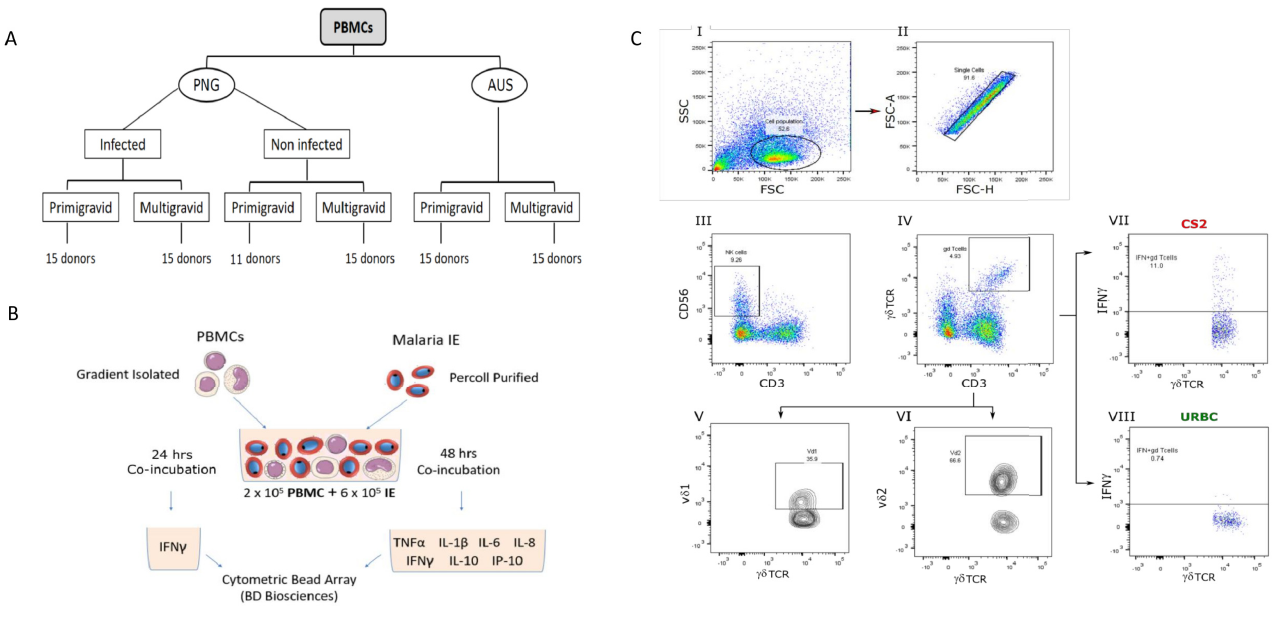
Fig 1. (A) Stratification of study population: PBMC derived from pregnant women from Papua New Guinea (PNG) and Australia (AUS) were categorized into six test groups based on sample origin, gravidity and current malaria infection. From PNG: infected primigravidae (15), infected multigravidae (15), non-infected primigravidae (11) and non-infected multigravidae (15). From Australian: primigravidae (15) and multigravidae (15). (B) Schematic representation of PBMC stimulation assay: PBMC were isolated by Ficoll gradient centrifugation and frozen at -80˚C. PBMC were thawed in batches and co-incubated with Percoll-purified infected erythrocytes (IE), phytohemagglutinin (PHA) or uninfected red blood cells (uRBC) for 24 or 48 hours. At 24 hrs, supernatants were measured for IFN γ , and cells harvested, stained and analyzed for intracellular staining. At 48 hrs, supernatant were analyzed for TNF- α , IFN- γ , IL-1 β , IL-6, IL-8, IL-10, and IP-10 by cytometric bead array. (C) Gating strategy for NK cells, γδ T cells and two distinct populations of γδ T cells (V δ 1 + and V δ 2 + ) producing IFN- γ . Live lymphocytes were identified using forward scatter (FSC) and side scatter (SSC) (I) before excluding cell doublets (II). Then, NK cells (CD3 - CD56 + ) (III), γδ T cells (CD3 + TCR + ) (IV), V δ 2 γδ T cells ( γδ TCR + V δ 2 + ) (V) and V δ 1 γδ T cells ( γδ TCR + V δ 1 + ) (VI) were gated on. Finally, the proportion (%) of each cell type producing IFN- γ was determined (e.g. proportion of IFN γ producing γδ T cells in response to CS2 IE (VII) and uRBC (VIII). Quadrants defining positive and negative cell populations were set according to single color controls. FACS plots are from one representative